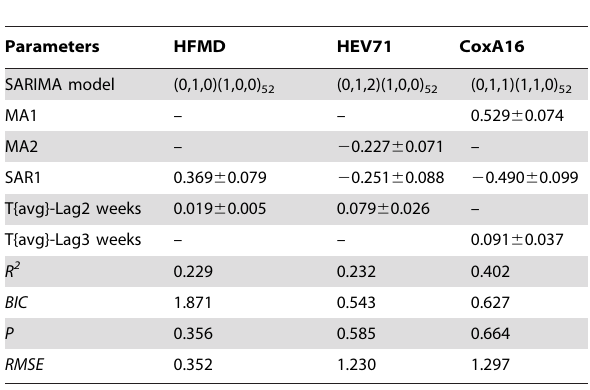
Table 5. Characteristics of multivariate SARIMA models